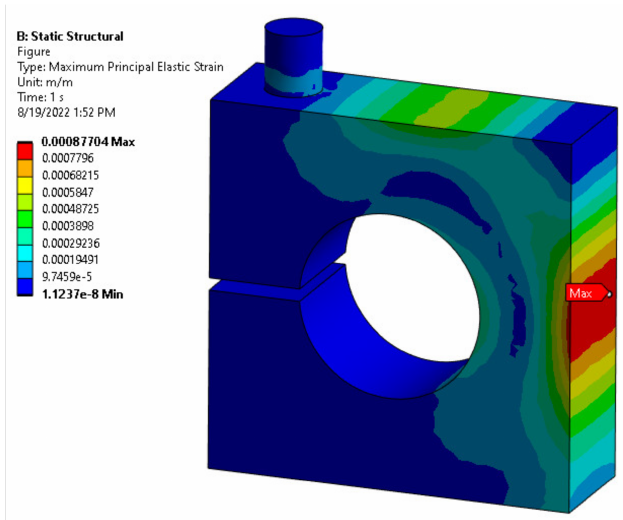
Figure 8. Von Mises stress FEM analysis.